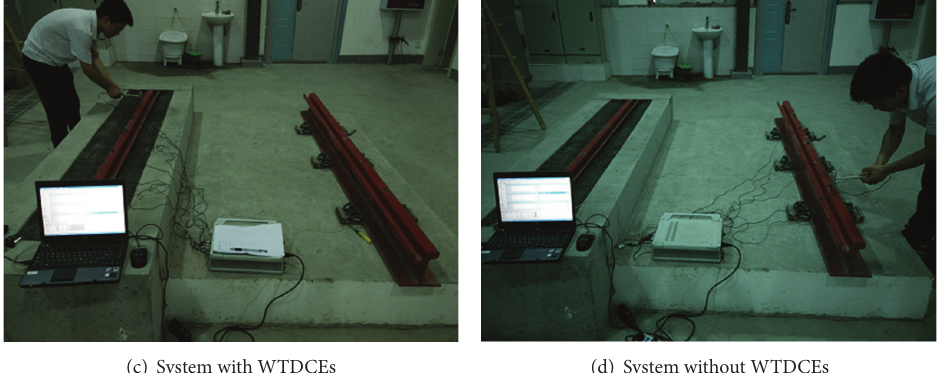
Figure 4: Modern tram track system with and without